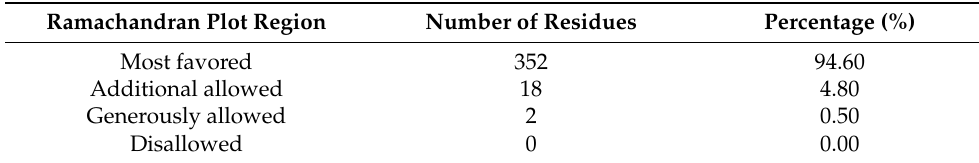
Figure 8. Homology model of pseudo Sbh26GST showing the canonical GST fold. ( A ) Ribbon representation of the model showing the presence of γ -glutamyl[S-(2-iodobenzyl)cysteinyl]glycine (stick formation). The two subunits are colored green and cyan . ( B ) Surface representation of the model showing the active site pockets of this multi-substrate enzyme. ( C ) One of the active sites in a monomeric unit. The 2-iodobenzyl moiety is oriented towards the hydrophobic binding site (H- site) shaded cyan ; the gamma-glutamyl-cysteinyl-glycine moiety is at the GSH binding site (G-site), shaded green . The dimer interface, also referred to as the ligand site (L-site), is shaded red . Table 3. The number and percentage of residues within the four regions of the Ramachandran plot (Figure